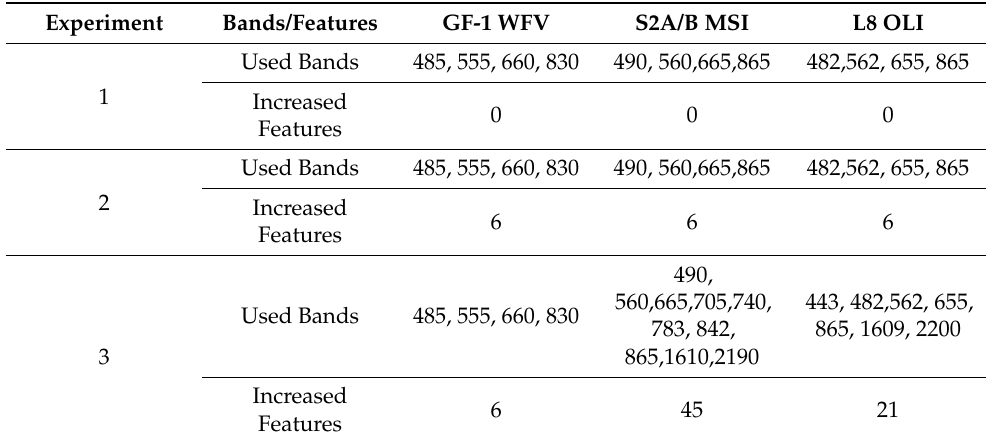
Table 5. The used spectral bands and the number of increased features for GF-1, S2 and